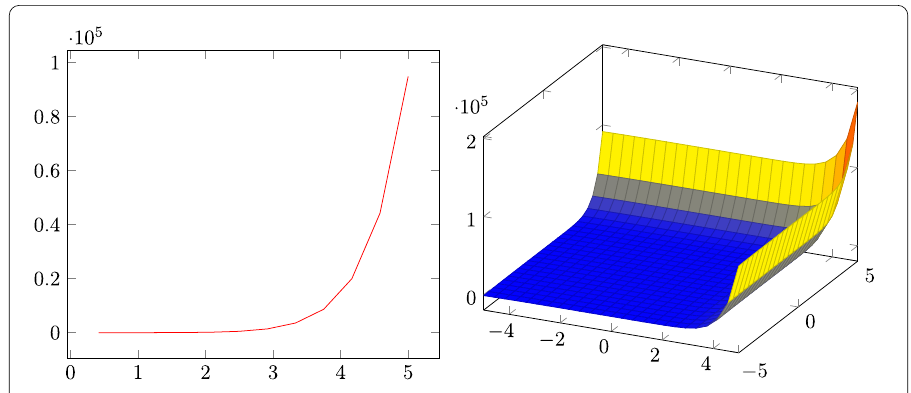
Figure 2 Minimization of 1D and 2D-problem (19) for f ( t , τ ) = ( e t – τ – 1) respectively. It is clear that minimization appears when t ∈